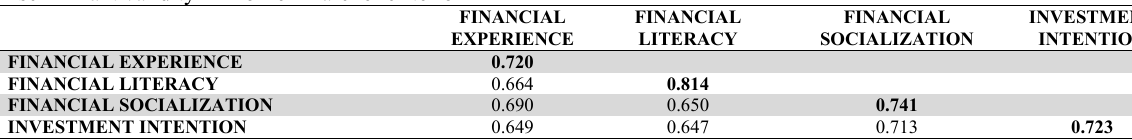
Discriminant validity — Fornell-Larcker criterion